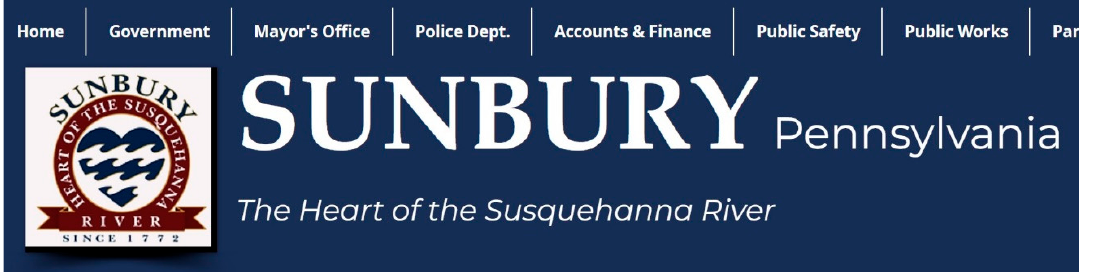
Figure 3. The recently adopted urban iconography at Sunbury, Pennsylvania [26].